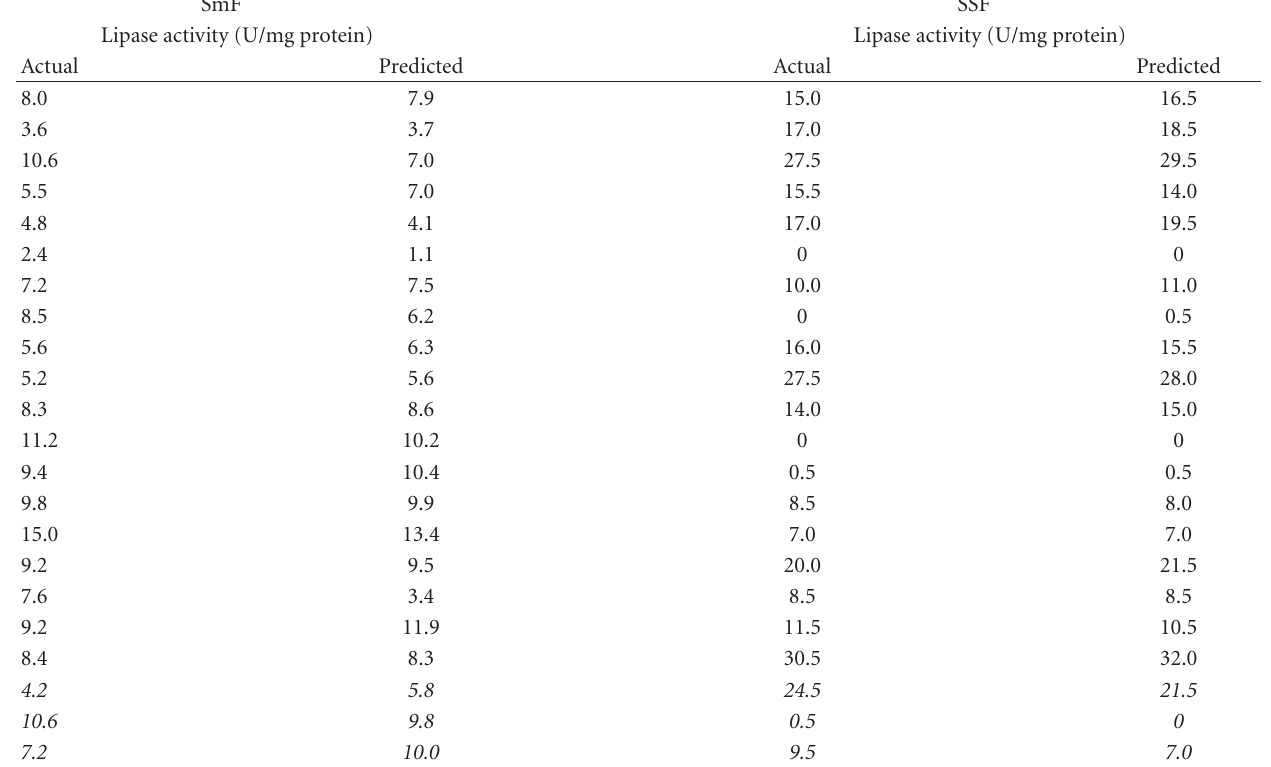
Table 3: Actual and ANN predicted lipase activities in SmF and SSF systems along with R 2 and AAD.